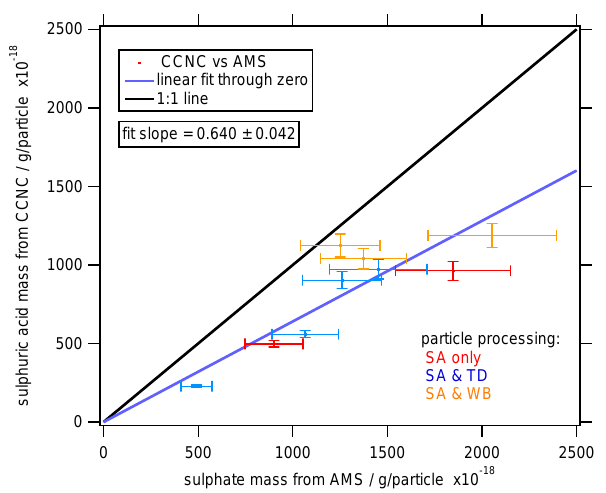
Fig. 9. Comparison of AMS sulphate per particle masses for 300nm particles to CCNC soluble mass per particle for the FROST2 cam- paign. Different treatments were used: SA only refers to sulphuric acid coating only, TD indicates that the thermodenuder was used and WB refers to the water